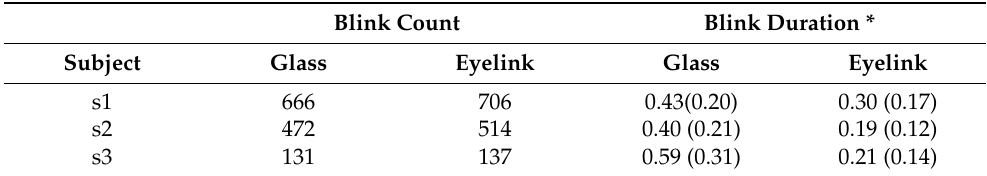
Table 1. Total number of blinks detected from the glass and EyeLink data and the average blink